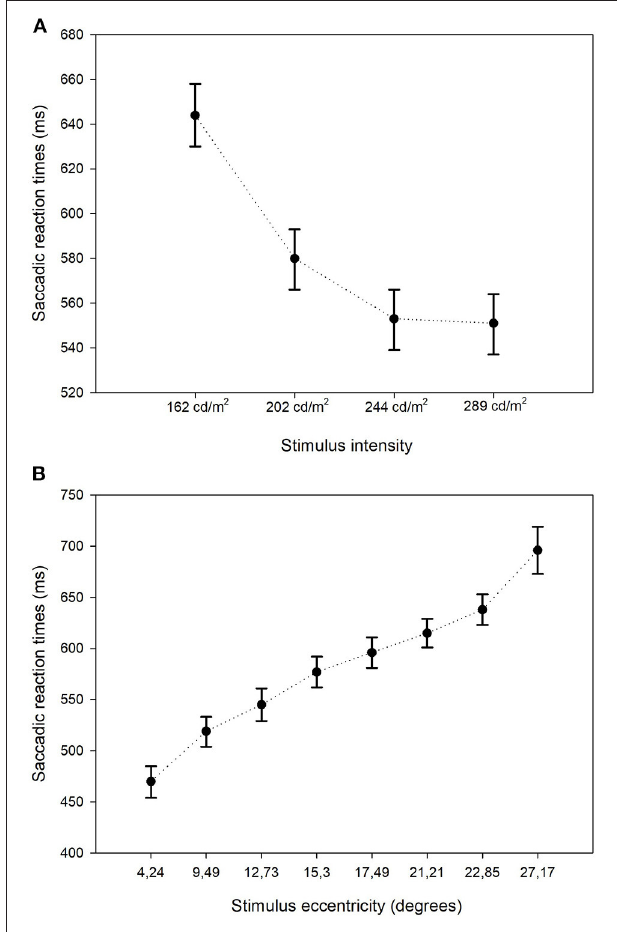
FIGURE 3 | Estimated mean saccadic reactions times: stimulus intensity and eccentricity. Estimated mean SRTs and their corresponding 95% confidence intervals stratified by stimulus intensity (A) and by stimulus eccentricity (B) .